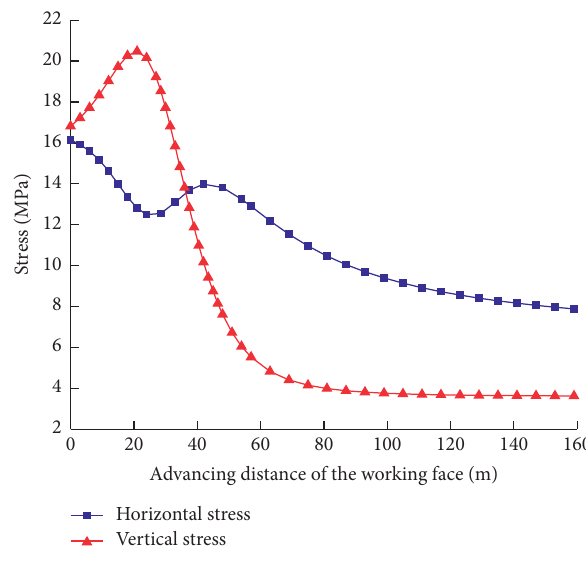
Figure 5: Schematic diagram of stress change.